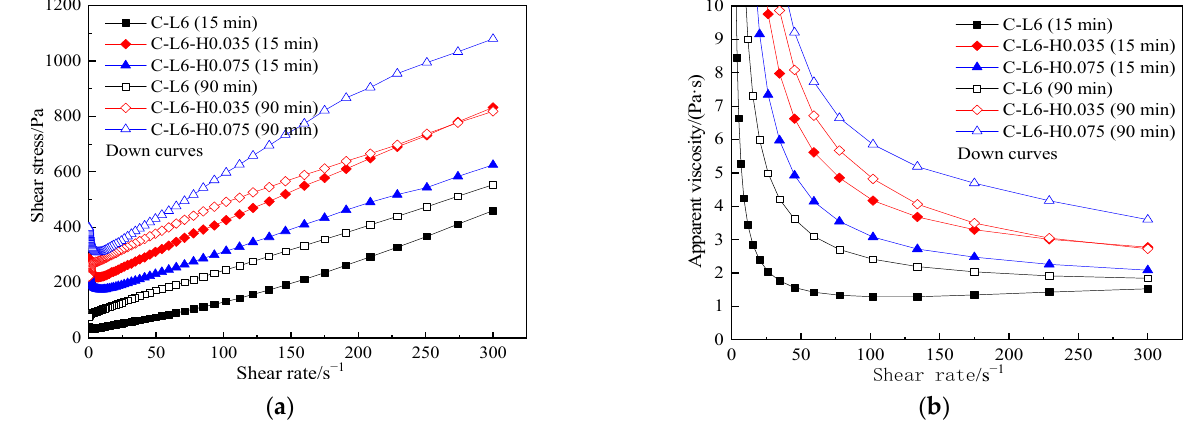
Figure 16. Rheological curves of C-L6-HPMC pastes. ( a ) shear stress vs. shear rate, ( b ) apparent viscosity vs. shear rate.